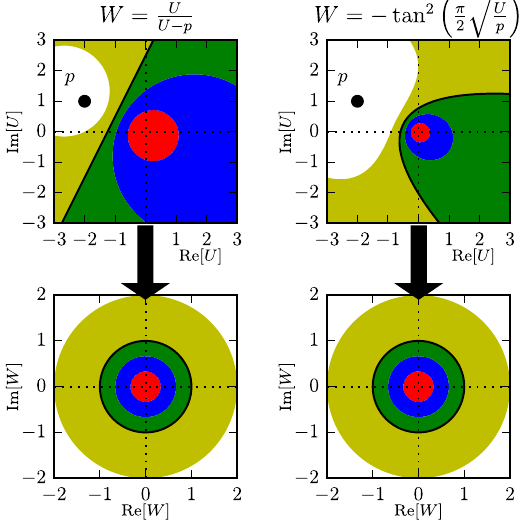
U Þ identified from the zeros of the 4. Poles of T K ð FIG. 5. Left: Euler map. Right: Parabola map. Top: Complex U 1 plane. Bottom: Complex W plane. The transformation maps the top regions of various colors onto the bottom regions of matching plane with truncation at the order of 6 (red squares), 8 (blue colors. In particular, the thick straight line (top left) and the points), and 10 (black stars). The black circle corresponds to parabola (top right) are mapped onto the unit circles (bottom left and right, of T . The stable points close to (cid:3) i 5 Γ correspond to true K U Þ . The exact zeros (small orange nonperturbative poles of T K ð arrows) are computed from the exact 1 =T series found with the K Bethe ansatz